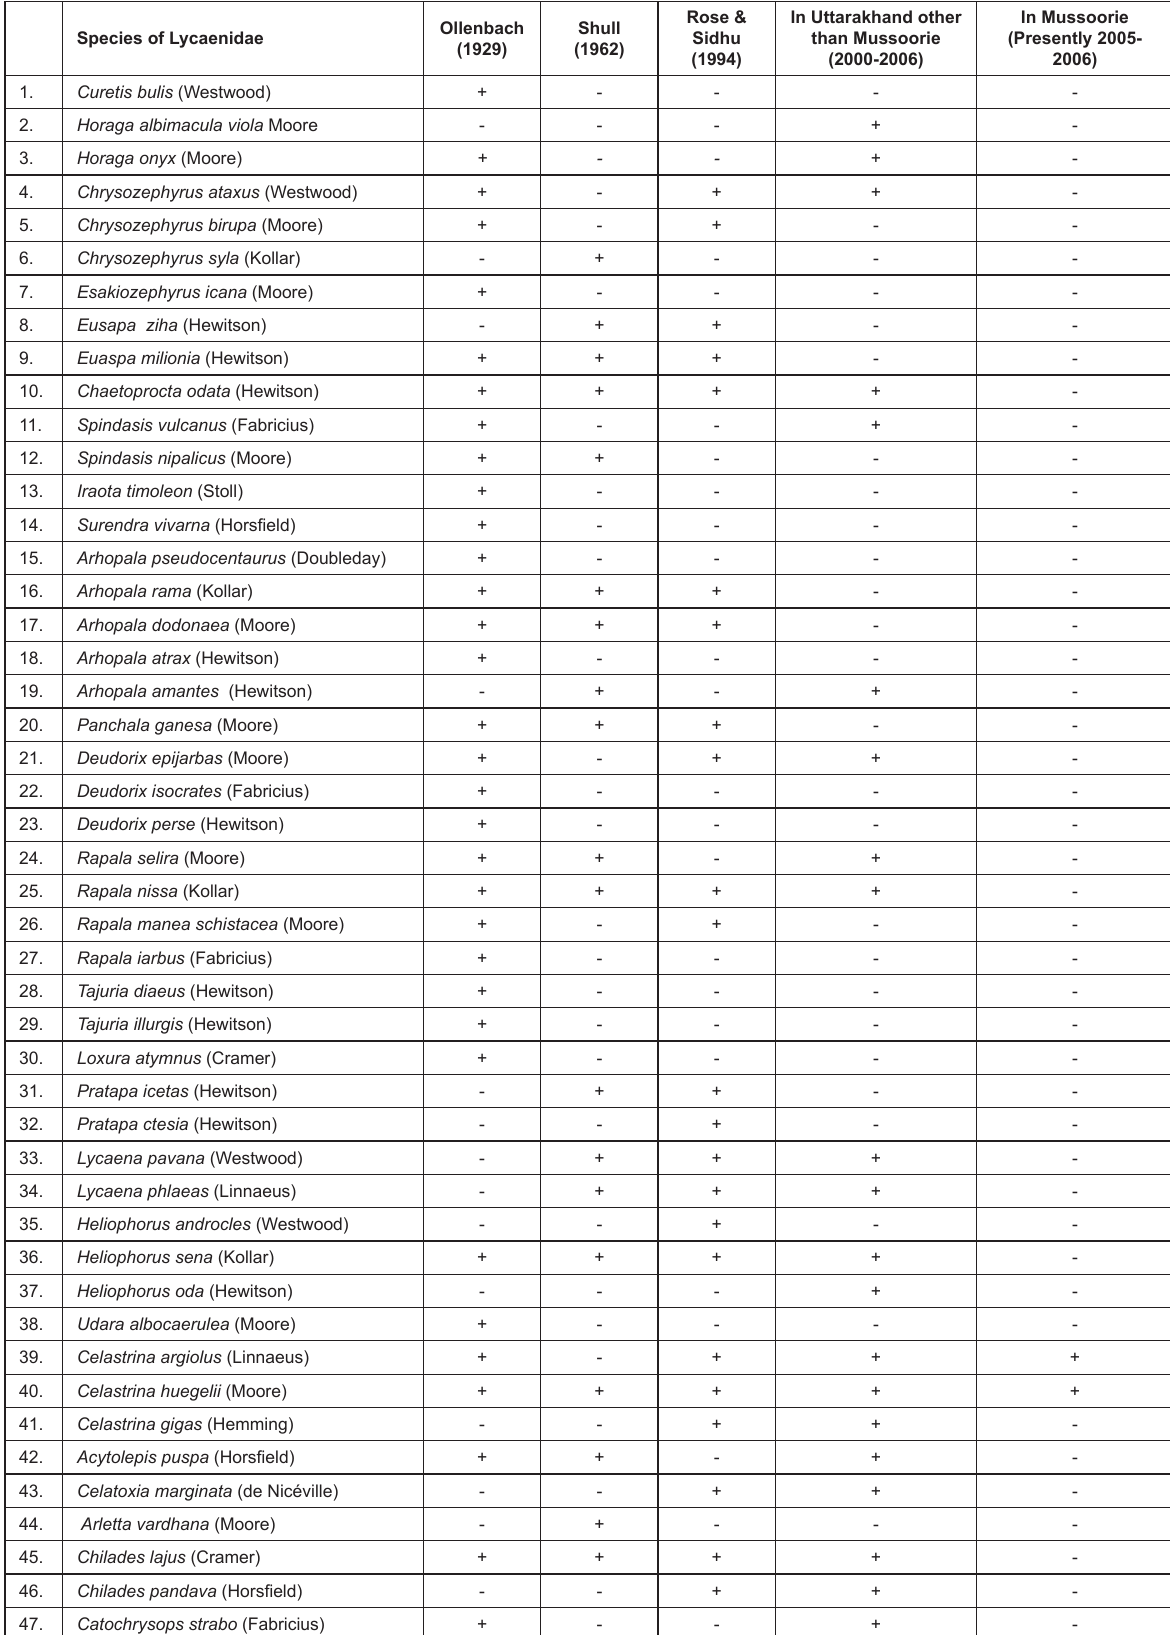
Table 1. Checklist of lycaenid butterflies of Mussoorie, Uttarakhand Species of